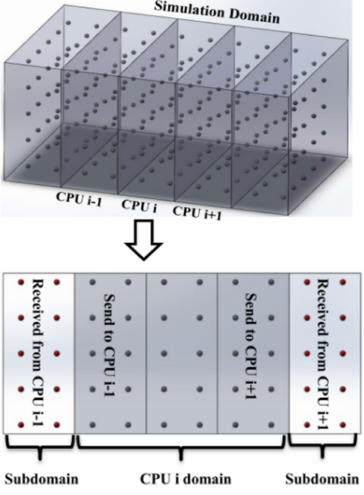
Figure 3. Domain partition and CPU topology for the MPI algorithm.